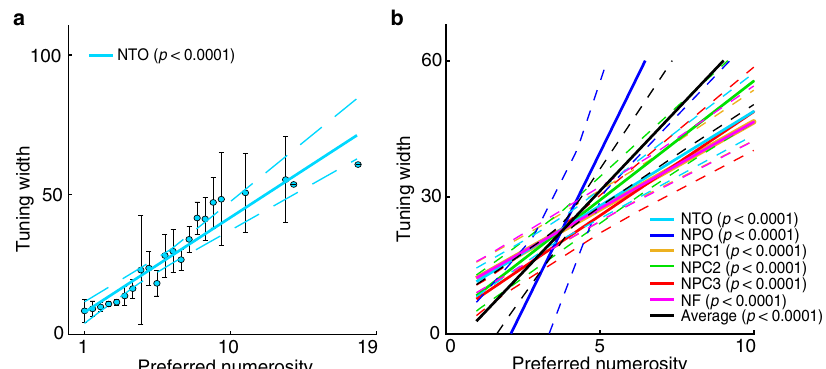
Fig. 4 Tuning width changes with preferred numerosity. a Tuning width increases with preferred numerosity in participant 1 ’ s NTO map elicited by the large range. Recording points are binned based on preferred numerosity. Points represent the mean tuning width within each bin, error bars represent the standard errors of the mean over all the data points within each bin. Solid line is the linear fi t to the bins, weighted by the inverse of the standard error of each bin. b Linear fi ts of tuning width against preferred numerosity of all the numerosity maps averaged across participants (solid coloured lines) and across maps (solid black line). In both ( a ) and ( b ): dashed lines represent 95% con fi dence intervals determined by bootstrapping fi ts to the binned points ( n = 1000). The statistical signi fi cance of the slopes was determined with permutation analysis ( n = 10,000), indicating the probability of observed tuning width change by